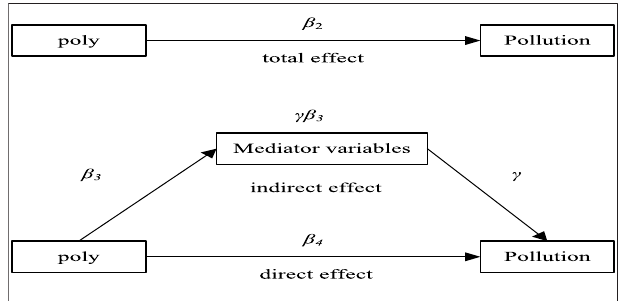
FIGURE 3 | The procedure of the mediating effect